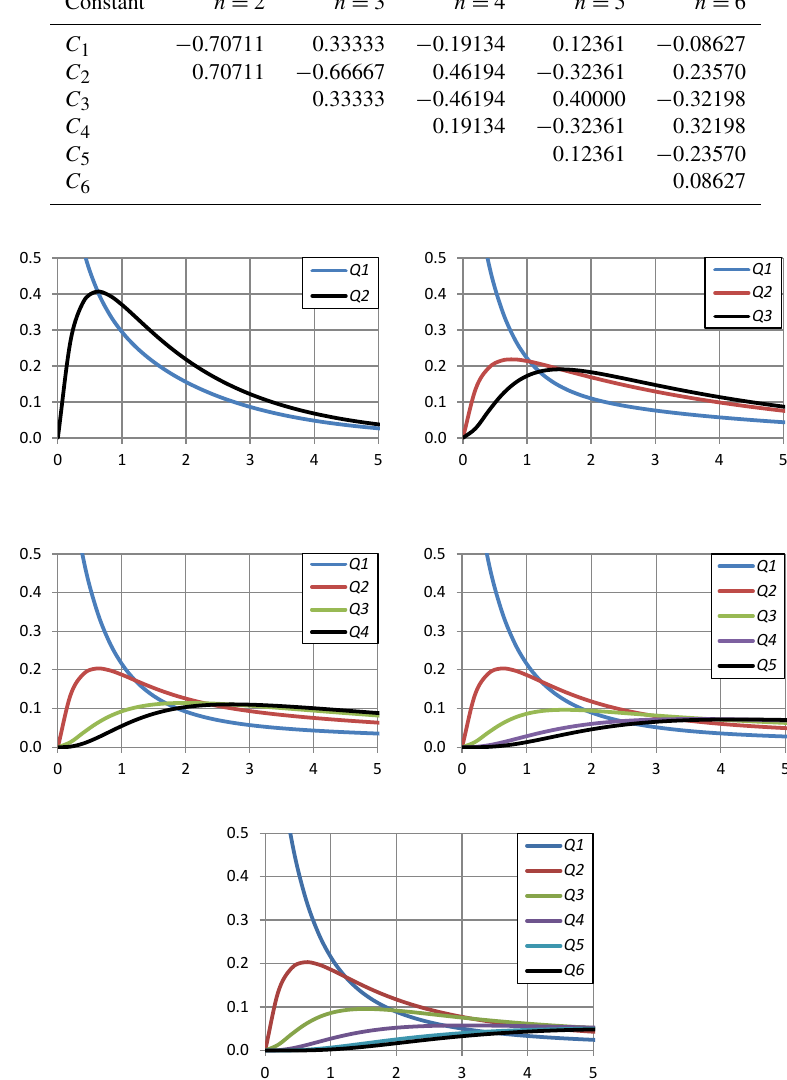
Figure 4. IUH at different numbers of reservoirs in the SC2 model ( k SC2 =